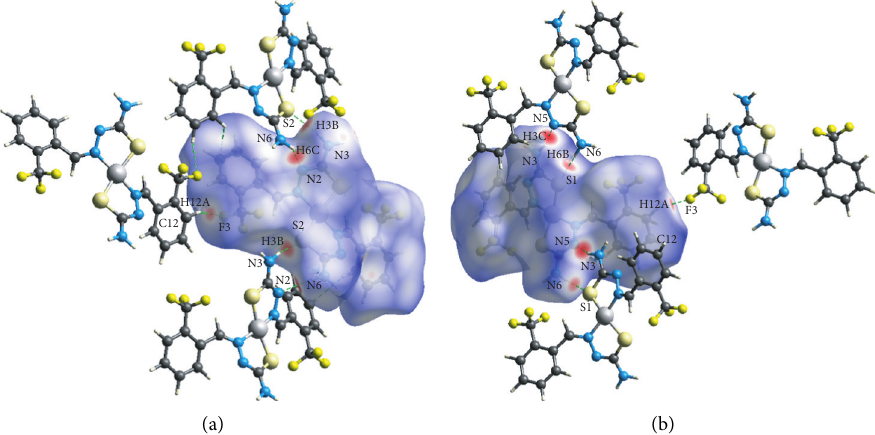
Figure 6: Neighbouring molecules associated with intermolecular hydrogen bonding on a d complex.